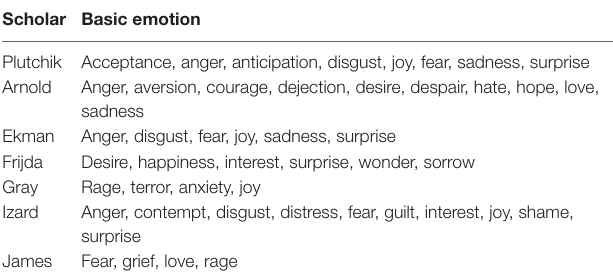
TABLE 1 | Definitions of basic emotions. Scholar Basic emotion